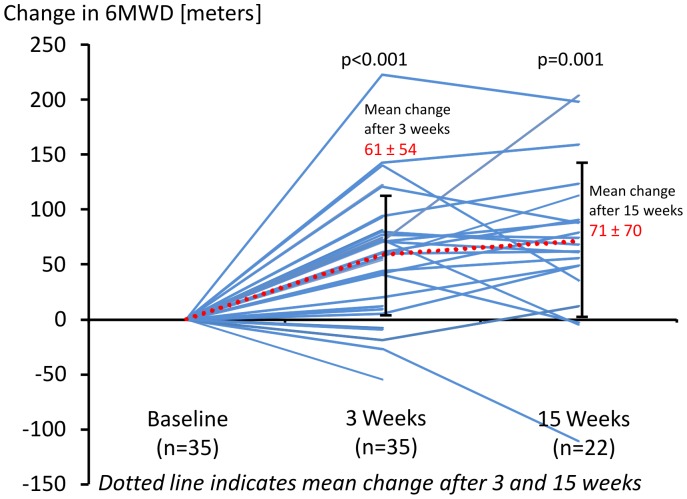
Individual changes in Six-Minute-Walking Distance (6MWD) after 3 and 15 weeks exercise training.With the use of Wilcoxon Rank Test according to baseline walking distance, p<0.001 was obtained for the comparison to baseline with weeks 3 (n = 35) and p = 0.001 with week 15 (n = 22). The dotted line indicates the mean change from baseline in 6MWD (61±54 meters and 71±70 meters).